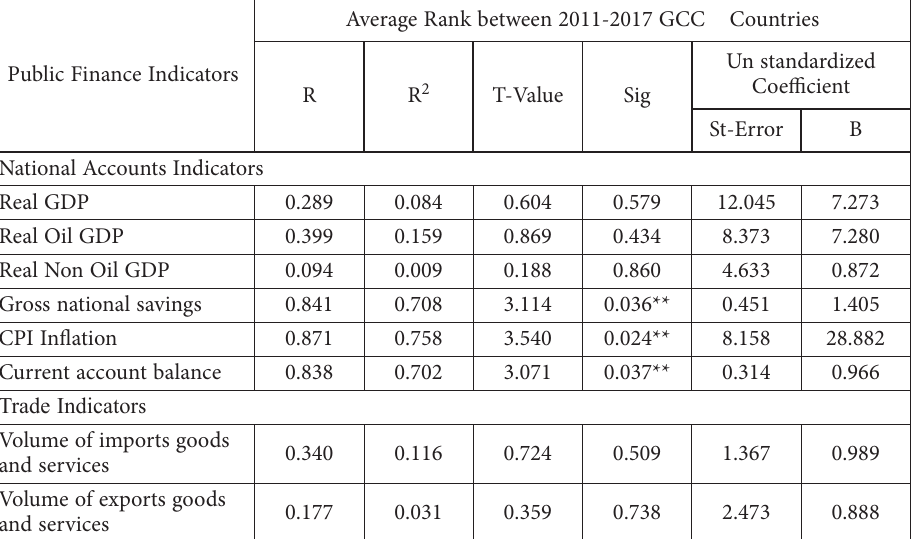
Table 10. Simple regression of public finance indicators on value of ten largest projects underway in the GCC countries (VTLPUC) (source: OLS regression analysis test from SPSS program. Denote *Sig at p <0.10 ** Sig at p< 0.05 *** Sig at p<